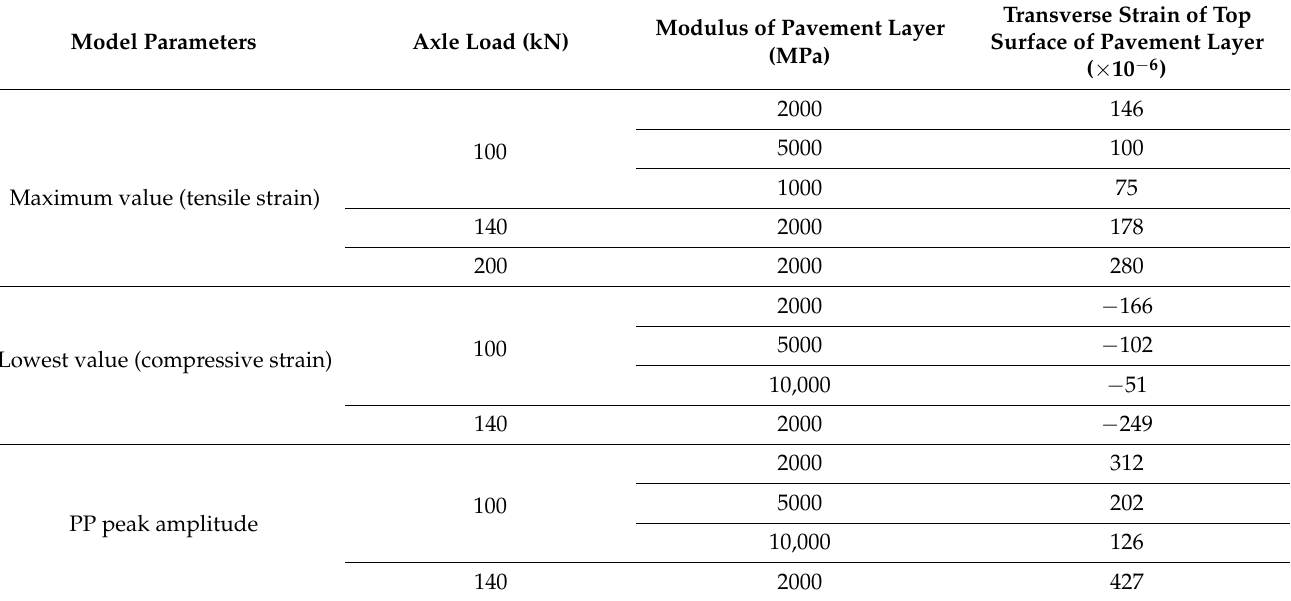
Table 2. Strain analysis data of pavement layer surface.